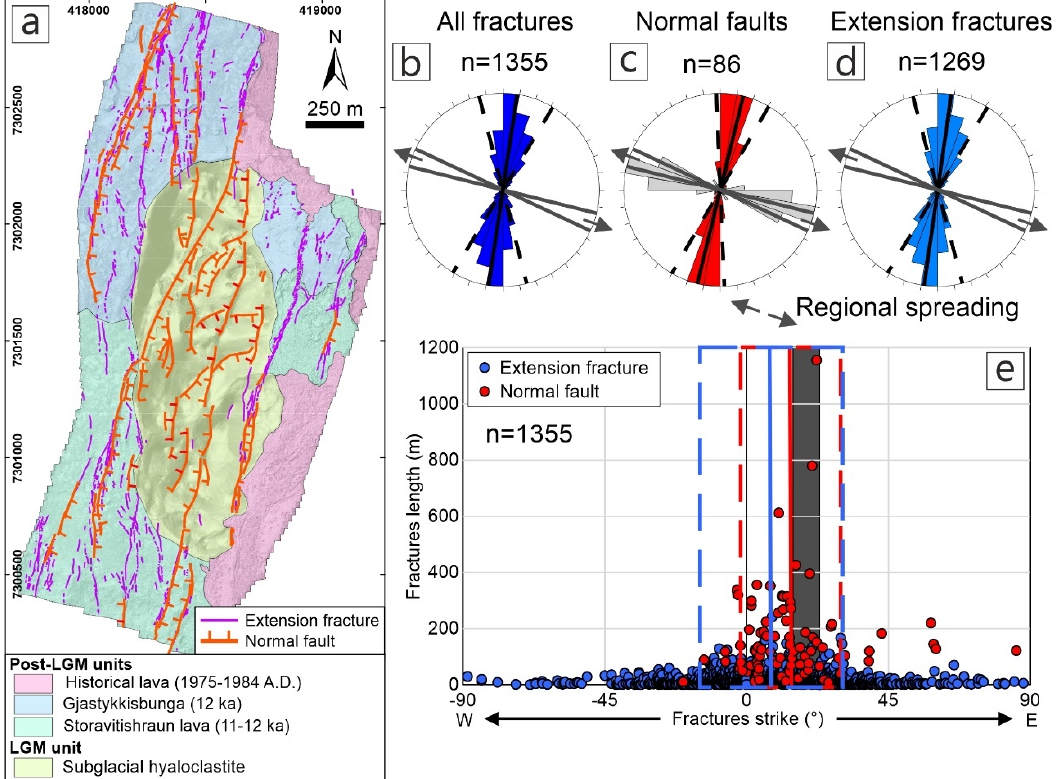
Figure 6. ( a ) Geological map of the area based on high-resolution outputs from SfM photogrammetry processing and field checks, reference system: UTM28-WGS84. LGM = Last Glacial Maximum; Rose diagrams representing the strike for the whole set of fractures ( b ), normal faults—including the dip direction of fault scarps—( c ) and for extension fractures ( d ). For each set the av. value and standard deviation is represented as continuous and dashed lines respectively, the regional spreading direction range is reported as dark grey lines. ( e ) Fracture strike vs. length (for both extension fractures and normal faults), av. value is reported as a continuous line, the SD range is represented as a dashed line (box), and the regional spreading direction range is represented as a dark grey rectangle.